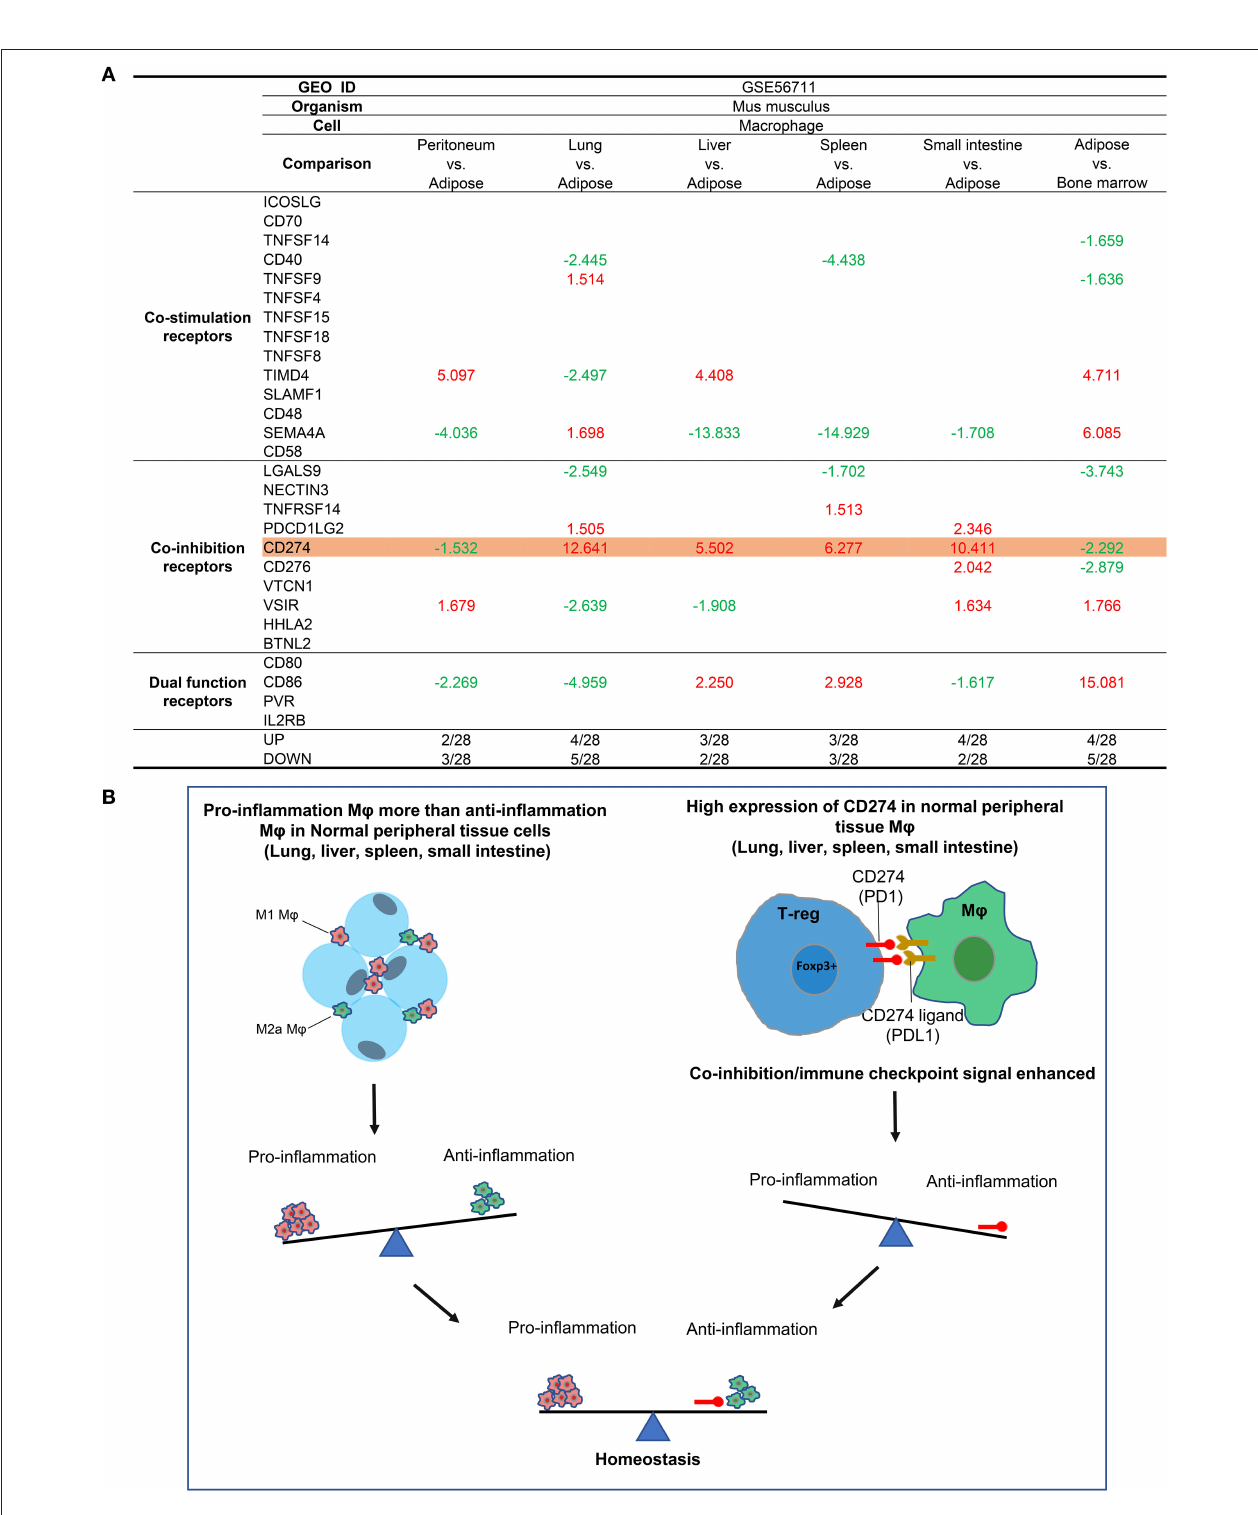
FIGURE 3 | Mechanism III: The macrophages (M ϕ ) from lung, liver, spleen, and intestine have differences in the expressions of T cell co-stimulation receptors, co-inhibition/immune checkpoint receptors, and dual-function receptors in comparison to that of ATM ϕ . (A) First, M ϕ from lung, liver, spleen and intestine express CD274 much higher than adipose tissue macrophages; second, the M ϕ from peritoneum and adipose tissue express lower levels of CD274 than that of bone marrow, suggesting that decreased expression of CD274 is a remarkable feature of adipose tissue macrophages; third, lung M ϕ upregulates the expression of TNFSF9, SEMA4A (co-stimulation), and PDCD1GL2 in comparison to lean ATM ϕ ; and fourth, liver M ϕ upregulates TIMD4 (co-stimulation) and CD86 (dual) in comparison to lean ATM ϕ . (B) The proposed model of A .